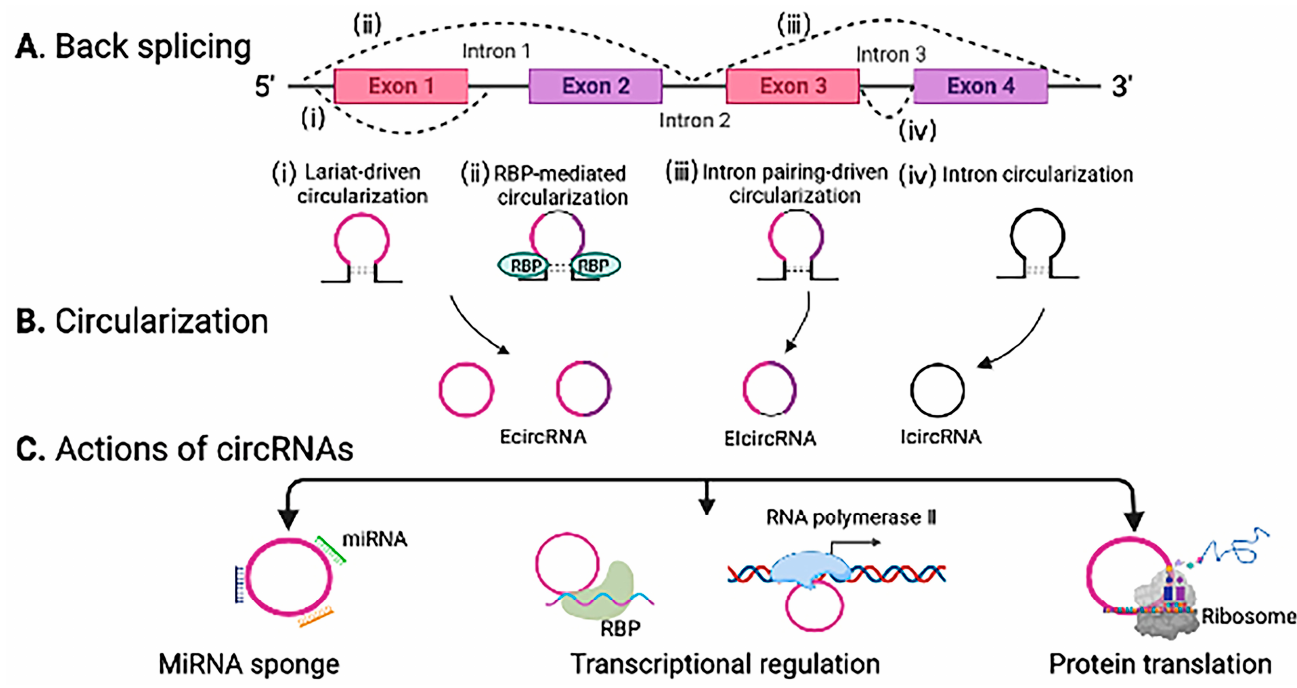
Figure 3. Circular RNA (circRNA) biogenesis and actions. ( A ) CircRNAs are generated by back- splicing of mRNAs on a 5 ′ splice site to a 3 ′ splice site. Back-splicing originates from (i) lariat-driven circularization, (ii) RNA-binding protein (RBP)-mediated circularization, (iii) intron pairing-driven circularization, and (iv) intron circularization. ( B ) Based on circularization, circRNAs are classi fi ed into exonic circRNAs (EcircRNAs), exon-intronic circRNAs (EIcircRNAs), and intronic circRNAs (IcircRNAs). EcircRNAs: an exon can omit splicing, leading to an intron-free transcript (from i in ( A )). The fi rst intron is detached and results in the 5 ′ splice site of exon 2 to be closer to the 3 ′ splice site of exon 1, leading to an ecircRNA with 2 exons (from ii in ( A )). EIcircRNAs are generated by circularization of exons and introns (from iii in ( A )). IcircRNAs originate from intron lariats that skip the standard intron debranching and degeneration (from iv in ( A )). ( C ) CircRNAs can sponge miRNAs, regulate transcription by interacting with RBPs or RNA polymerase Ⅱ , and encode pro- teins.